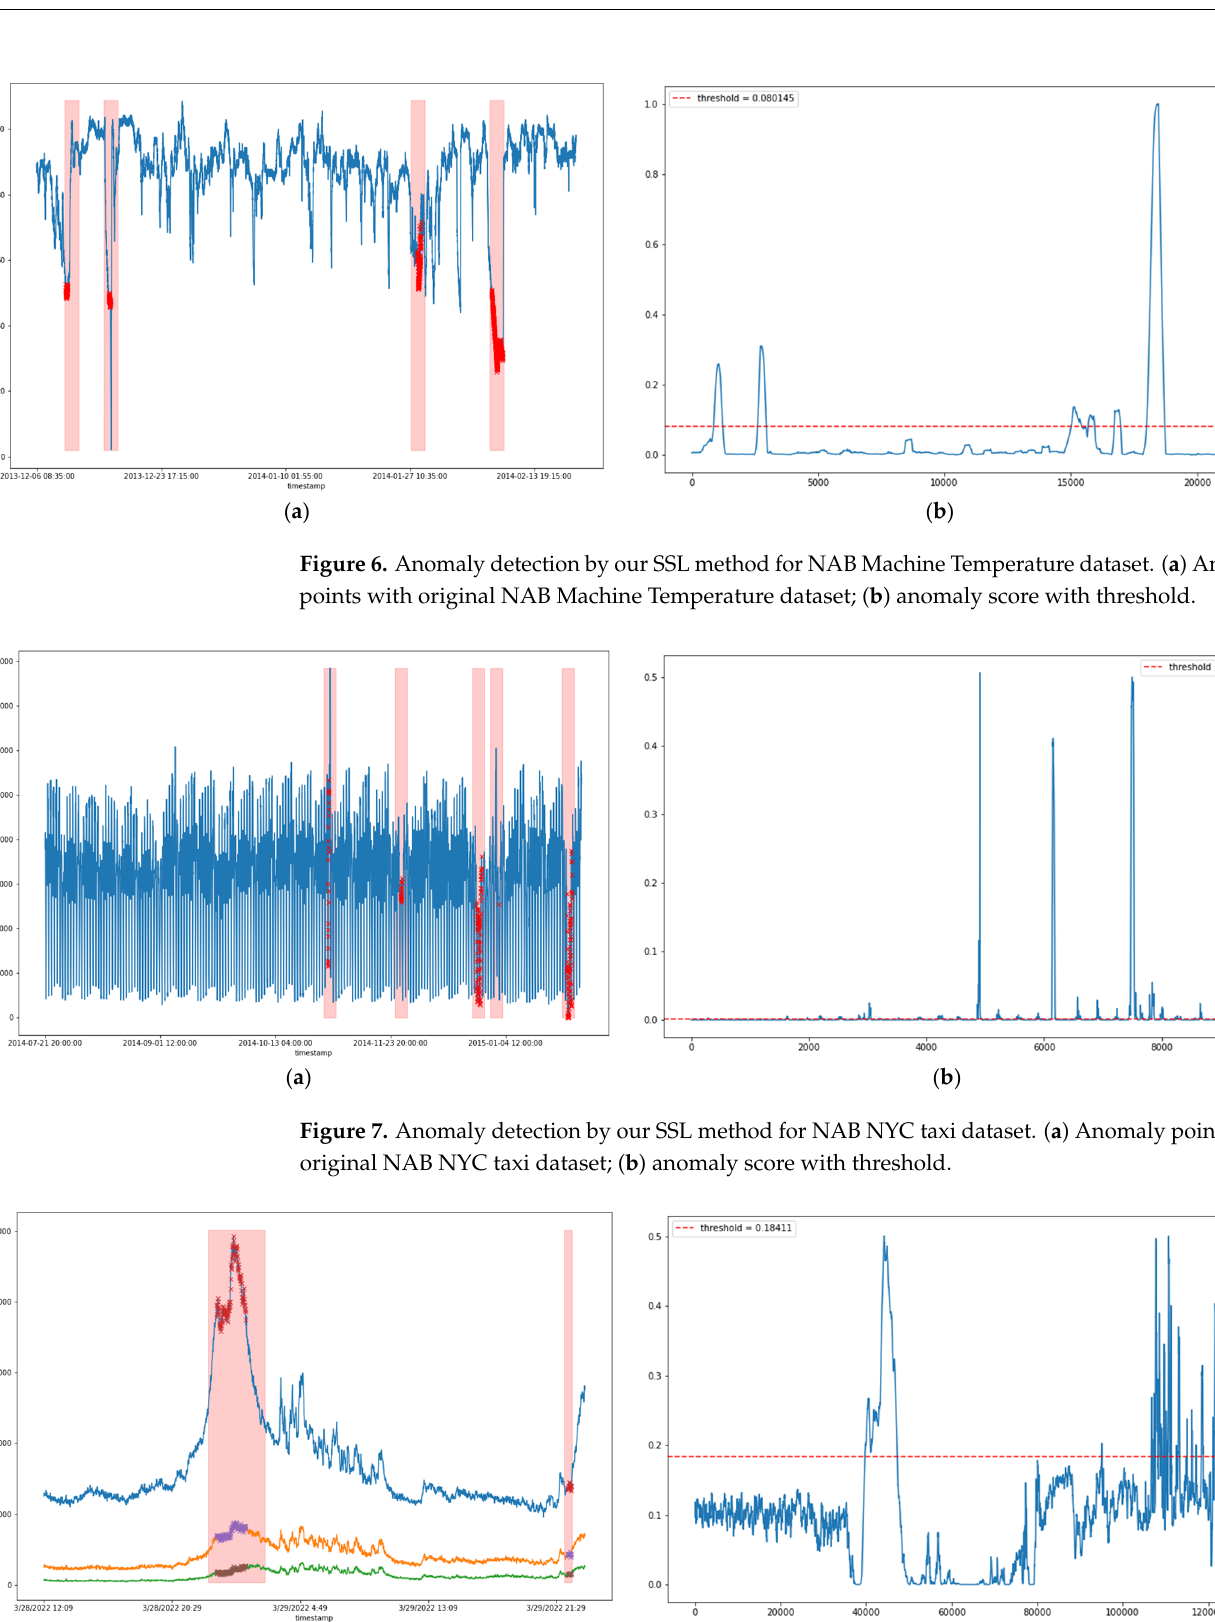
Figure 5. Anomaly detection by our SSL method for NAB Artificial With Anomaly dataset. ( a ) Anom ‐ aly points with original NAB Artificial With Anomaly dataset; ( b ) anomaly score with threshold.